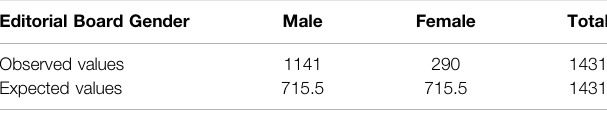
TABLE 1 | Total observed and expected values by gender of the composition of the editorial board.